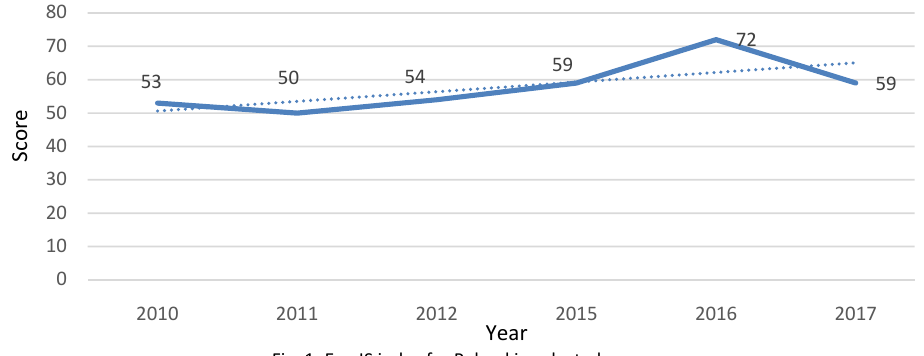
Fig. 1: Eco-IS index for Poland in selected Fig. 1: Eco‐IS index for Poland in selected years